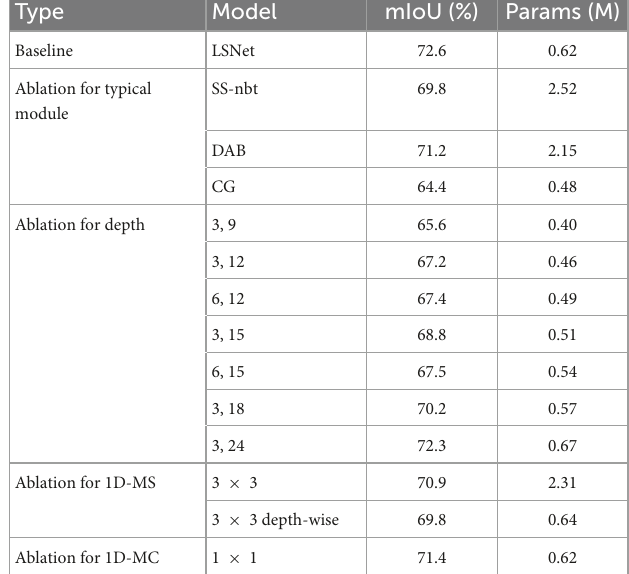
TABLE 2 Ablation study results of 1D-mixer